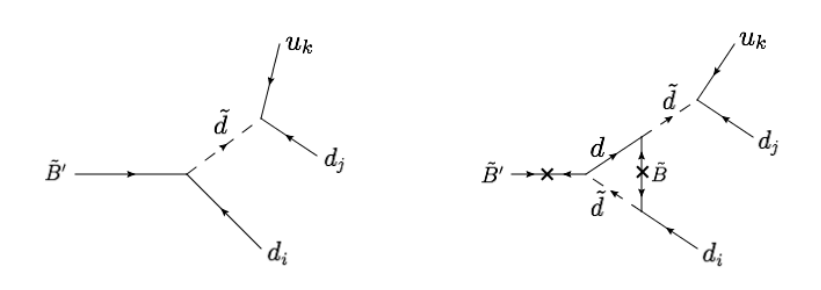
Figure 1 . Tree and loop level decays of the hidden gaugino ~ B 0 that interfere to produce a baryon asymmetry. The crosses in the second diagram represent mass insertions, necessary to introduce the phases on the two gaugino masses that give rise to the CP asymmetry in the interference